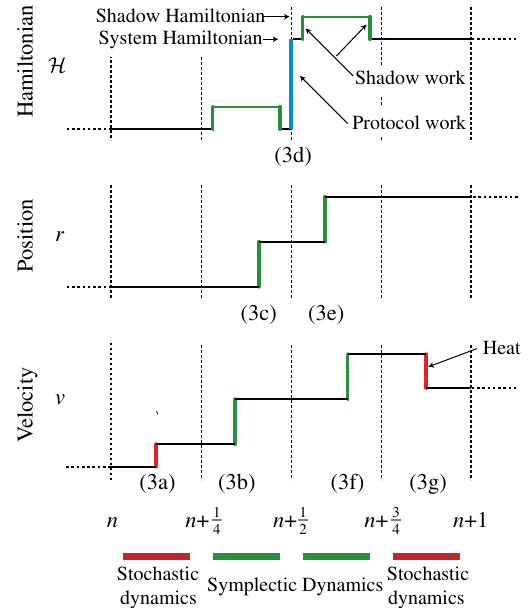
FIG. 1. Timeline fortheLangevinintegrator (3).Thepart labels (a)–(g) correspond to the substeps of Eq. (3). The stochastic substep (3a) randomizes the velocity, transferring heat between the system and environment, while the Hamiltonian is fixed and the position unchanged. We then switch from the system to the shadow Hamiltonian, performing shadow work on the system. Substeps (3b) and (3c) update the velocity and then the position according to the symplectic dynamics of the shadow Hamiltonian, exactly conserving the energy. We next switch back to the system Hamiltonian (performing shadow work), and in (3d) update the system Hamiltonian from H ð n Þ to H ð n þ 1 Þ , according to the prescribed protocol (cid:2) . This action performs protocol work on the system. We switch back to the shadow Hamiltonian (doing shadow work), symplectically update position and then velocity (3e) and (3f), and then restore the system Hamiltonian (again performing shadow work). Finally, we conclude with another velocity-randomization substep